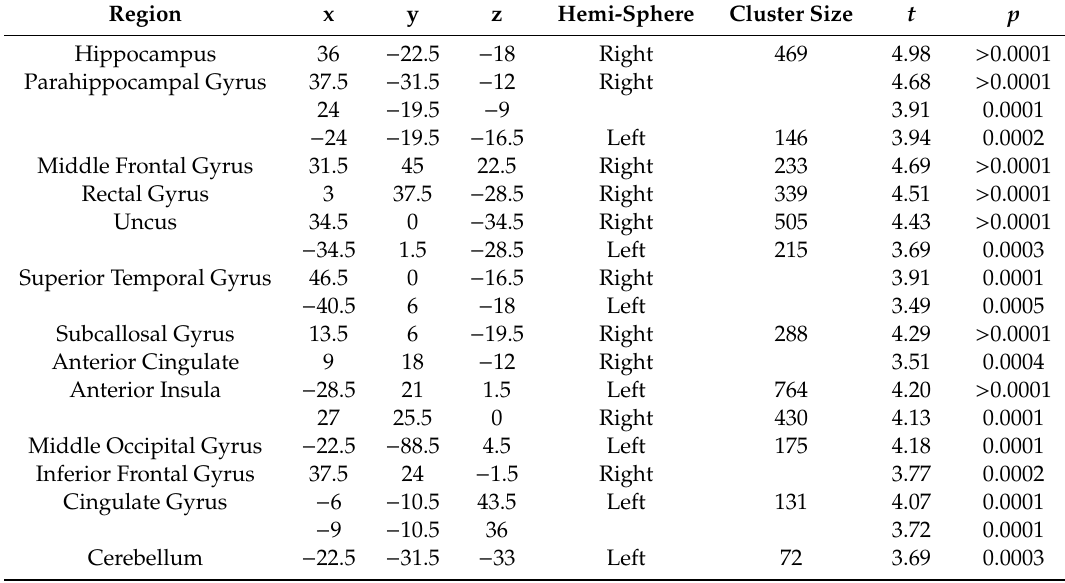
Table 2. Regions with reduced grey matter density in FM compared to HC. Age was included as covariate of no interest. t -test at the whole brain level, thresholded at p < 0.001 uncorrected. Region x